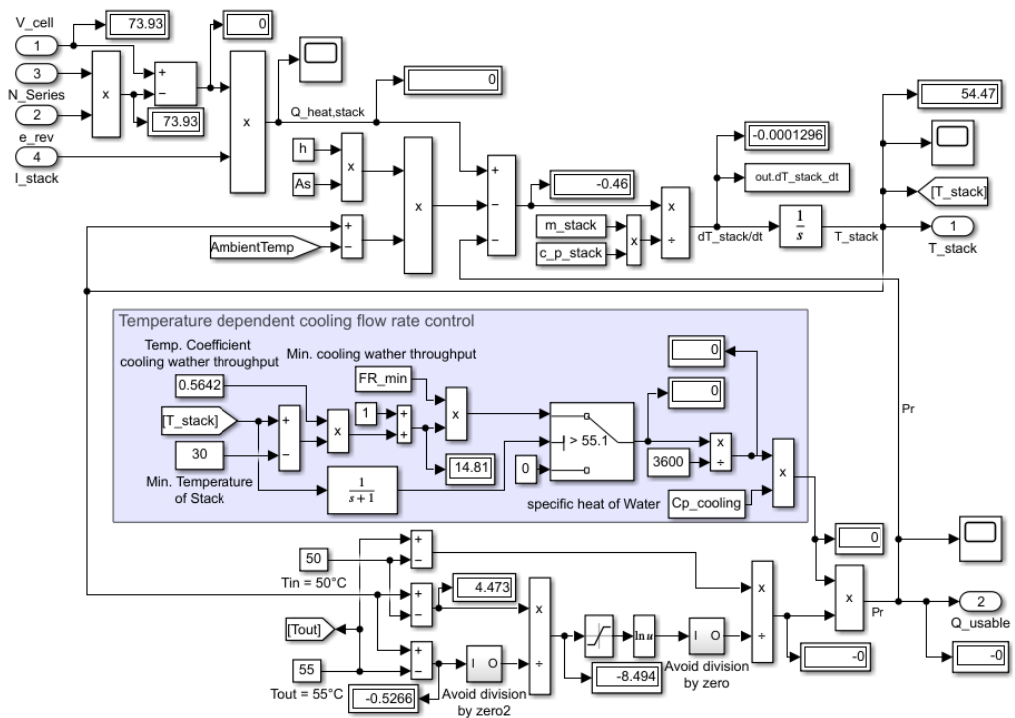
Figure 10. Calculation of waste heat generated by the electrolyser including coolant flow rate control and operating temperature calculation of the electrolyser (some parts based on [41 – 43]).